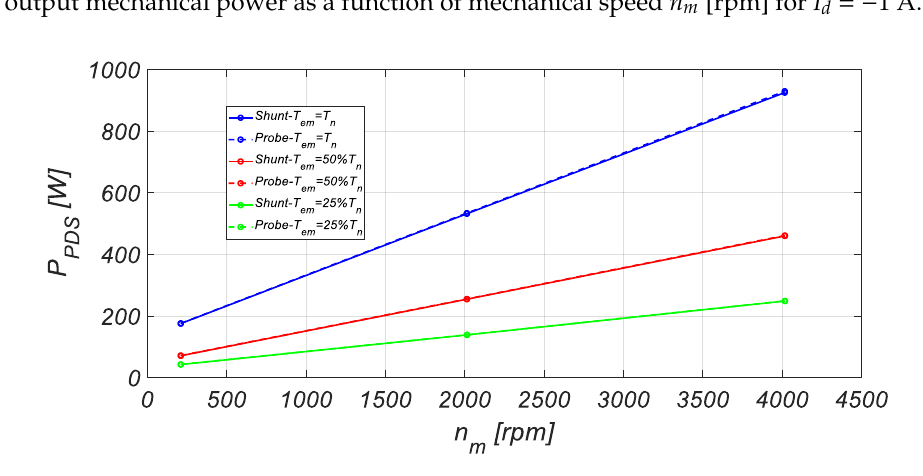
Figure 6. Mechanical power measured at I d = −1 A. From the acquired values of active power, it is possible to determine both the power losses and the efficiency of the entire PDS under test. For instance, Table 11 reports the efficiency detected for each working point at I d = −1A. Table 11. Efficiency detected for each working point at I d = −1 A. Working Points